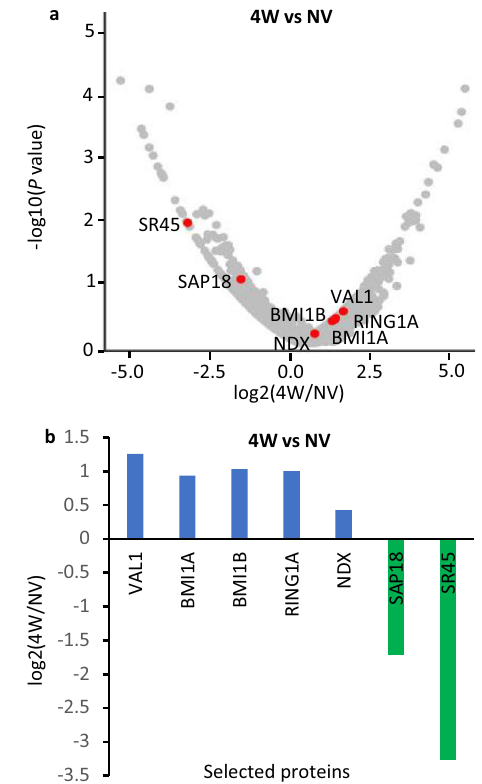
Fig. 1 | VAL1 proteomic interactors as identi fi ed by CoIP-MS. a Volcano plot showing relative protein abundance in log2 ratio of 4 weeks cold (4W) to non- vernalized(NV).Proteinsofinterestarelabelledandhighlightedinred. b Barplot showing relative protein abundance in log2 ratio of 4 weeks cold (4W) to non- vernalized (NV) for selected proteins. Blue bars show proteins with increased abundance upon transfer to cold, green bars show proteins with decreased abundance upon transferred to